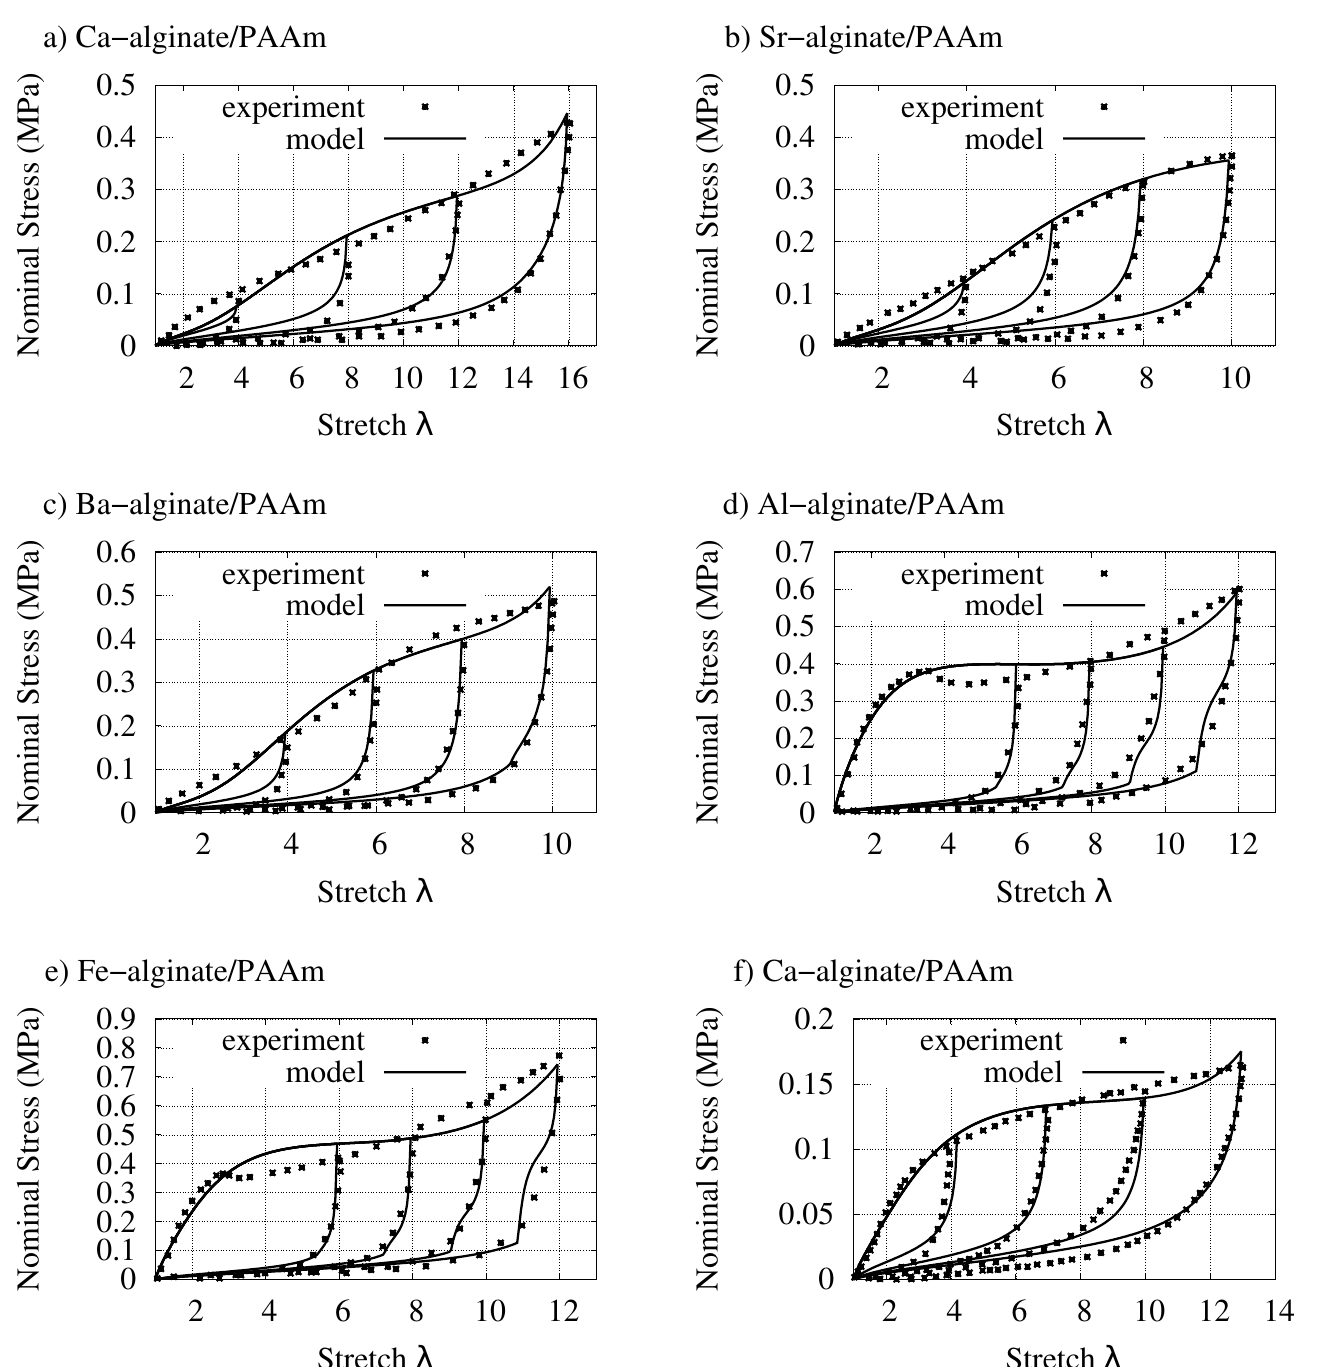
Figure 2. Comparison of the model with the quasi-static cyclic tensile test data of various alginate-PAAm DNHs. ( a – e ): by Yang et al. [23] and ( f ): by Sun et al.